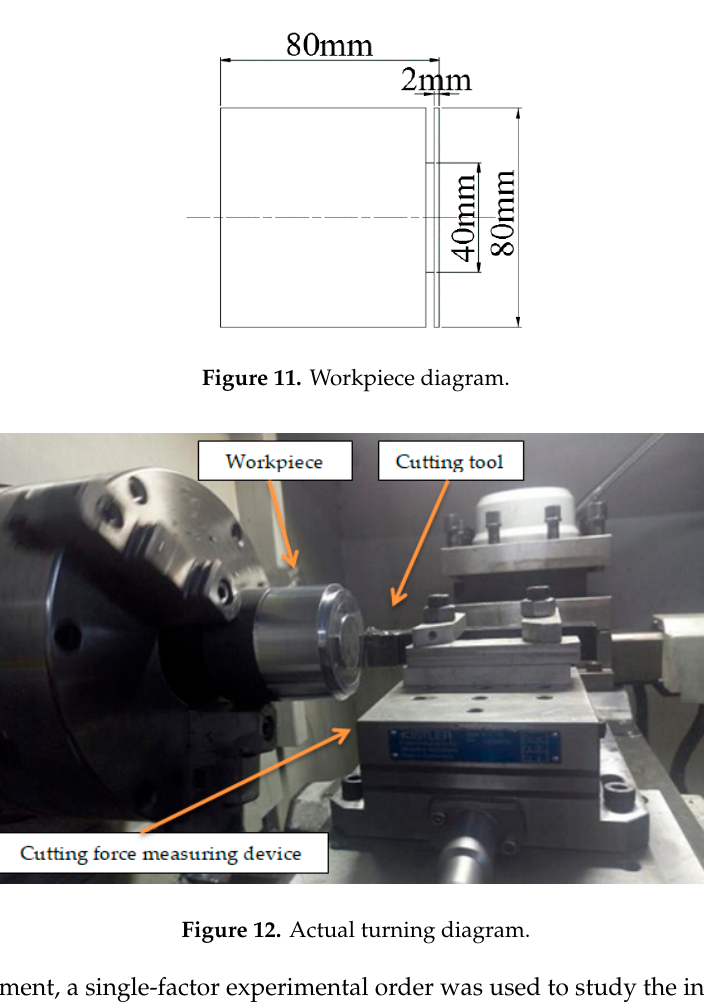
Table 8. Single factor orthogonal cutting experimental parameters.